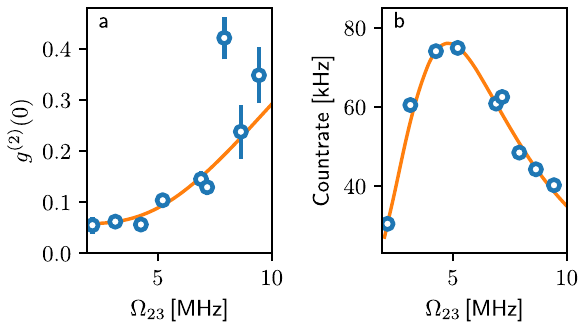
Fig. 6 Zeno blockade. a The equal-time correlation value for different driving strengths Ω 23 for Ω 12 /2 π = 300 kHz. b The measured photon rate of the cavity output for the same measurement. The orange lines show a quantum simulation of the simpli fi ed system with a position averaged coupling constant of g /2 π = 9.2 MHz and a (slight) amplitude correction of the photon production rate to accommodate the data. The error bars in a and b represent one standard deviation and are too small to be visible for some of the data